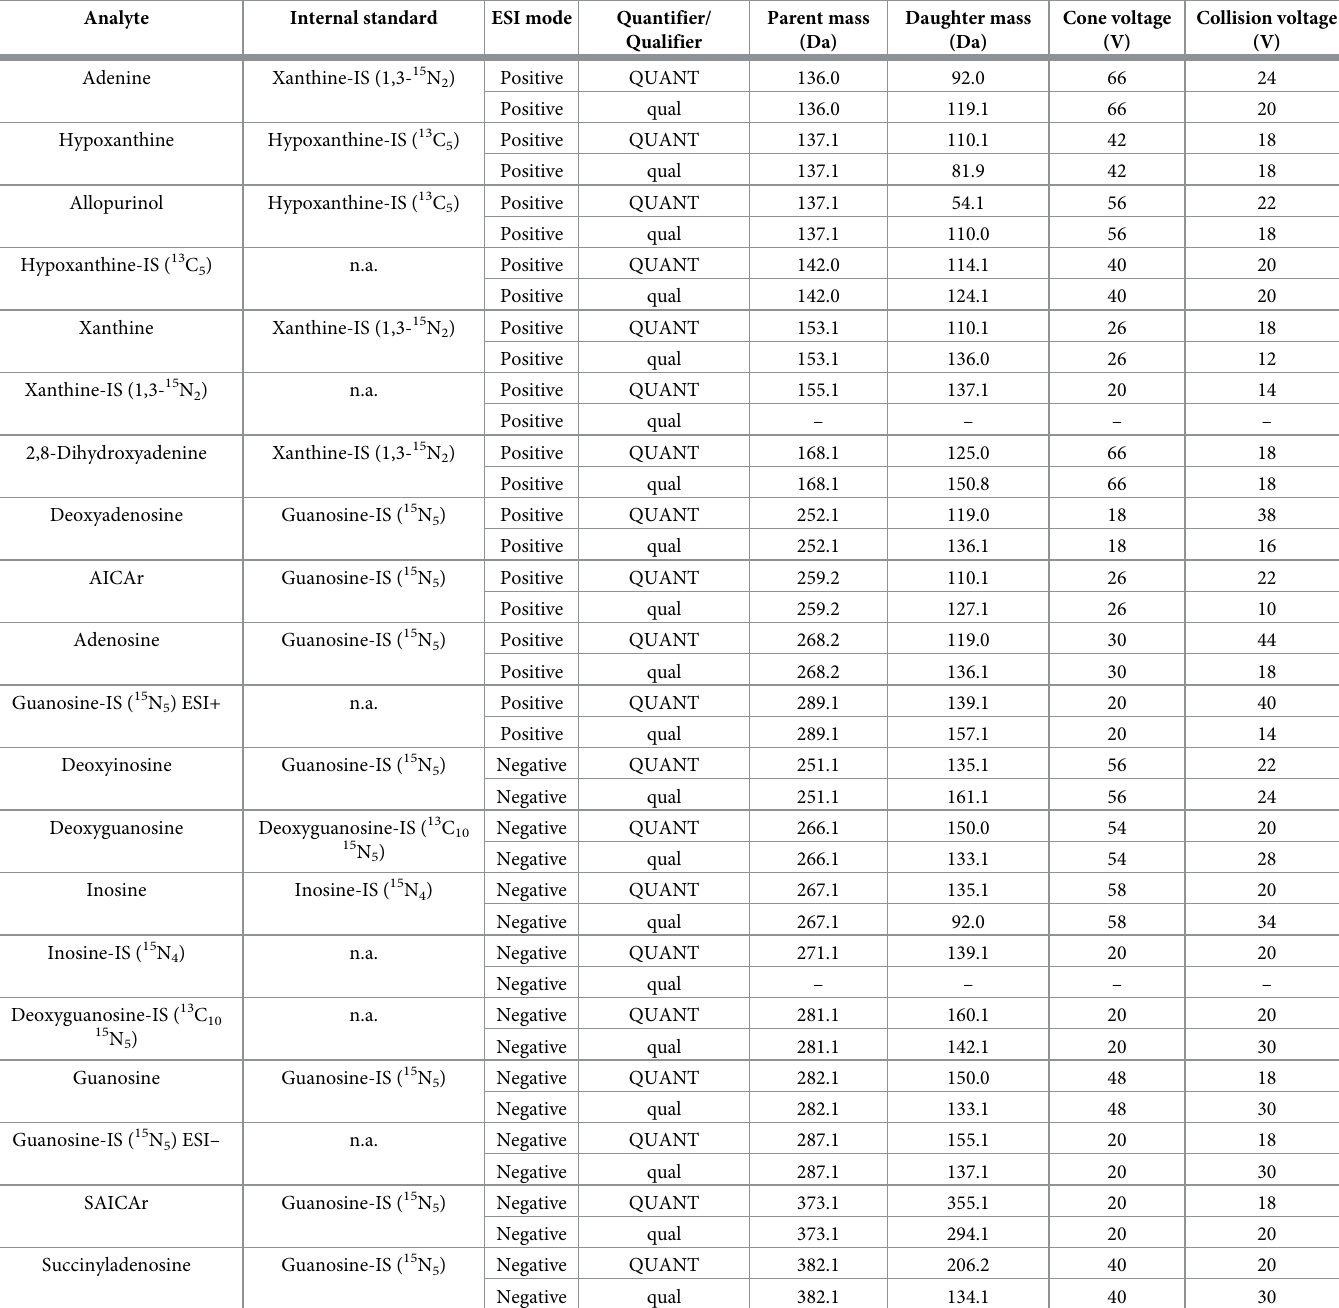
Table 1. Optimized MS/MS settings of purines and related